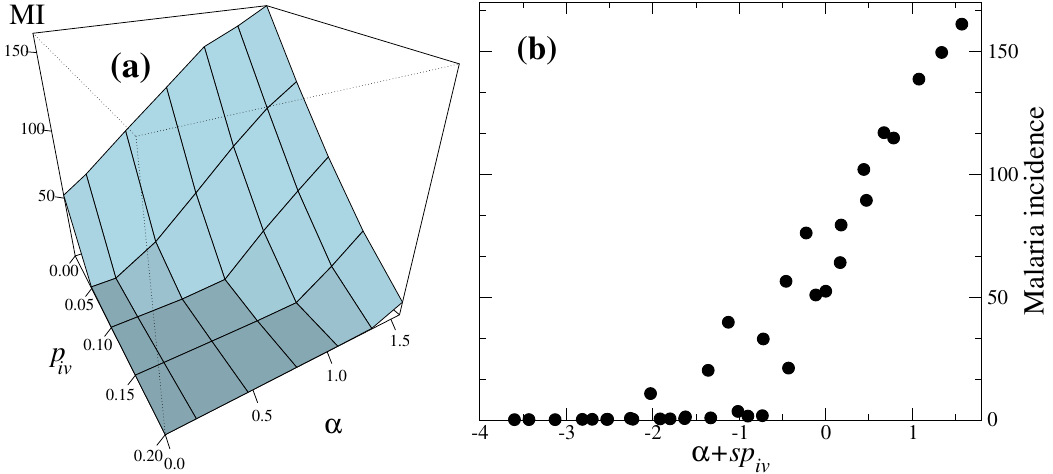
Figure 3. ( a ) Malaria incidence as a function of the heterogeneous affinity α and the ivermectin probability p iv , showing that isolines of malaria spreading are approximately a linear combination of both variables. ( b ) Malaria incidence as a function of the linear combination α + sP iv with s = − 18, showing a transition from disease persistence to elimination. In all cases, the human-to-mosquito transmission efficiency is held constant at w h =